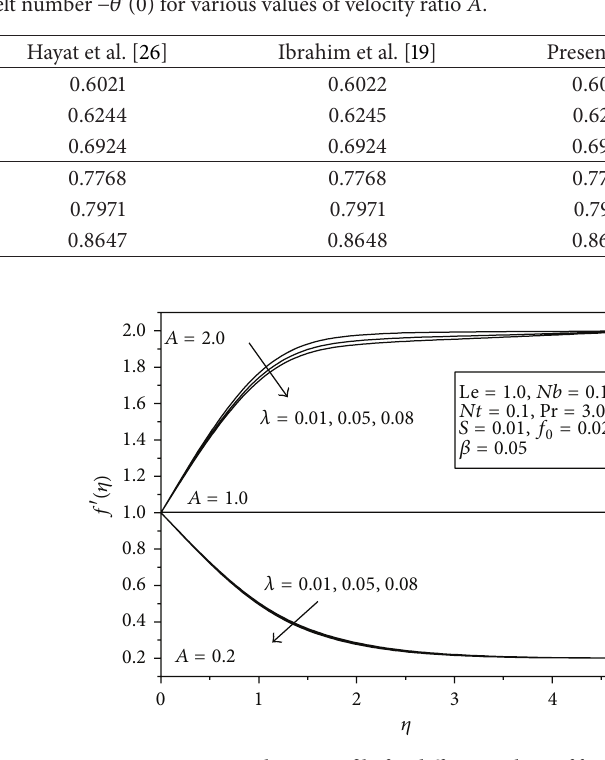
Figure 6: Velocity profile for different values of 𝜆 .